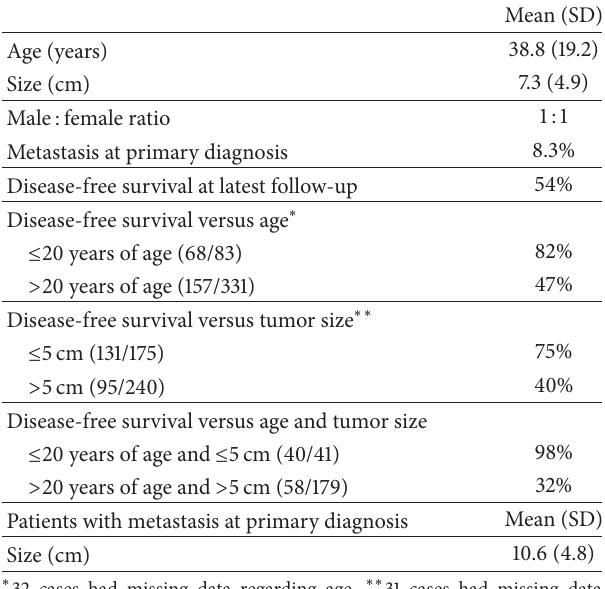
Table 1: Data on all synovial sarcomas from the SSG Central